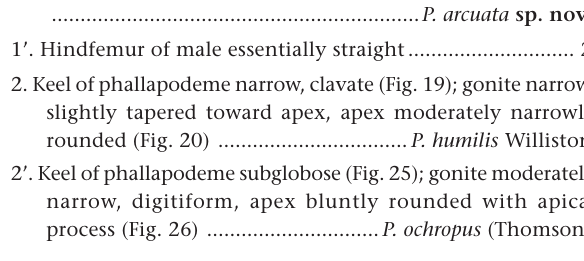
Key to Species of Parydra from Brazil